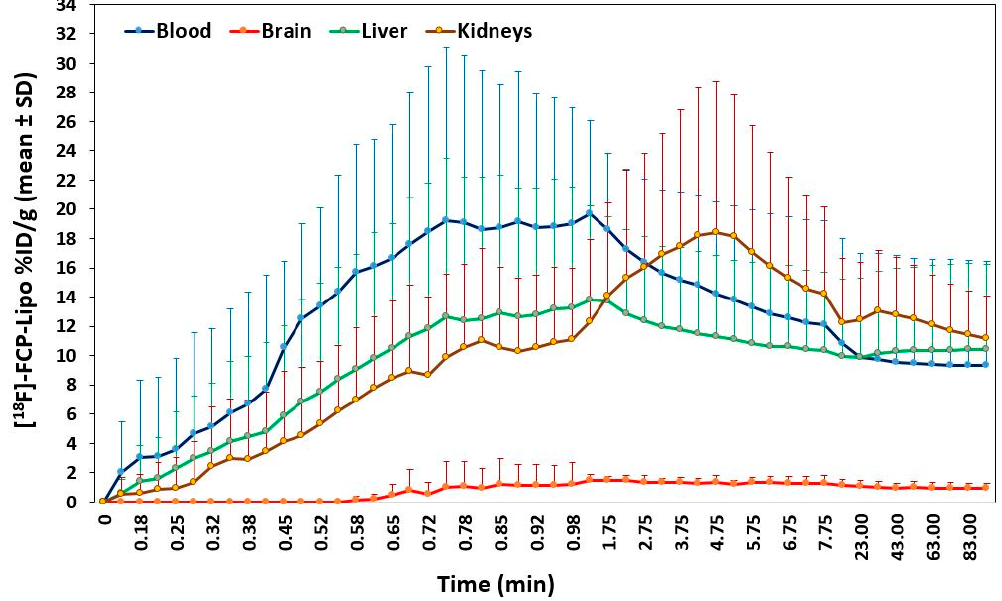
Figure 4. Time-activity curve data ( n = 3) generated from the dynamic PET image dataset of [ 18 F]-FCP encapsulated liposomes shows the time-dependent kinetics and tissue clearance in mice.